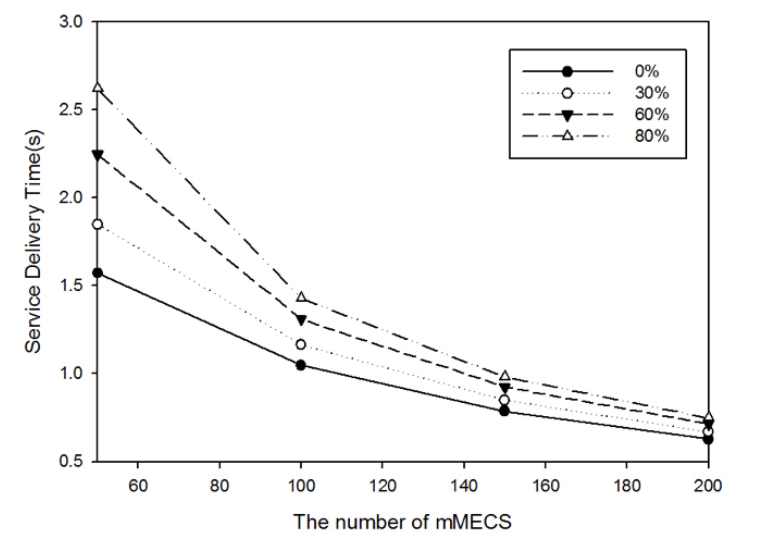
Figure 10. Service delivery time (Task sizes: 3000MI).